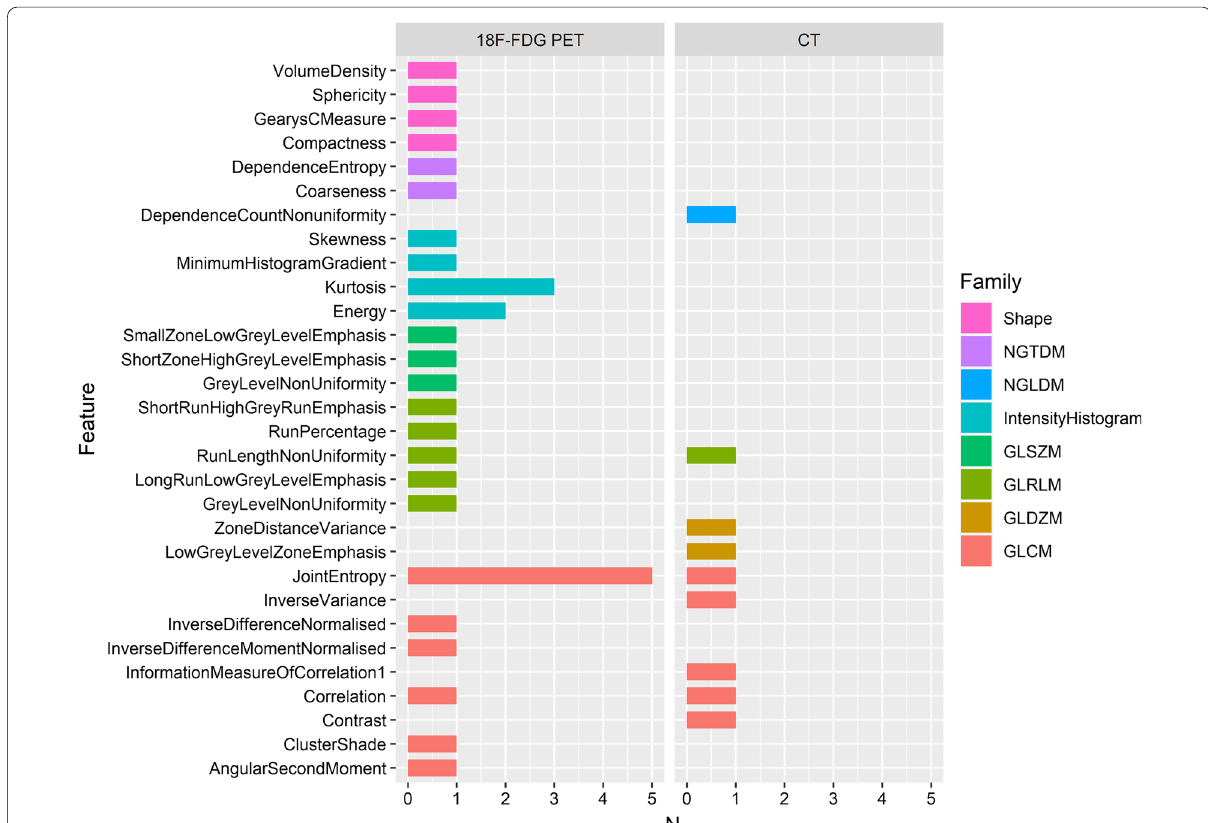
Fig. 3 Histogram of radiomic feature recommendations by modality, excluding image transforms. Up to five features were extracted from each study, according to significance or model contribution. GLCM grey-level co-occurrence matrix, GLDZM grey-level distance-zone matrix, GLRLM grey-level run length matrix, GLSZM grey-level size zone matrix, NGTDM neighbouring grey tone difference matrix, NGLDM neighbouring grey-level dependence